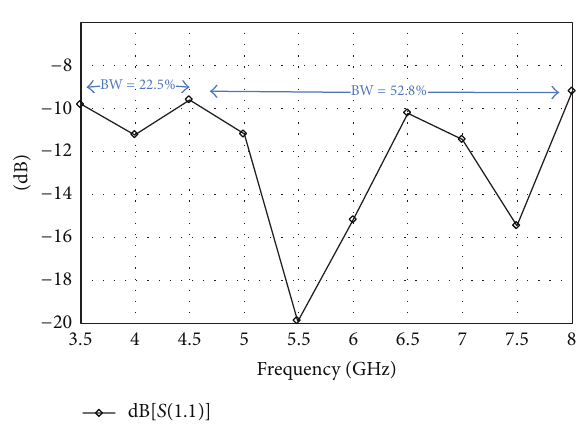
Figure 6: Return loss for proposed antenna.